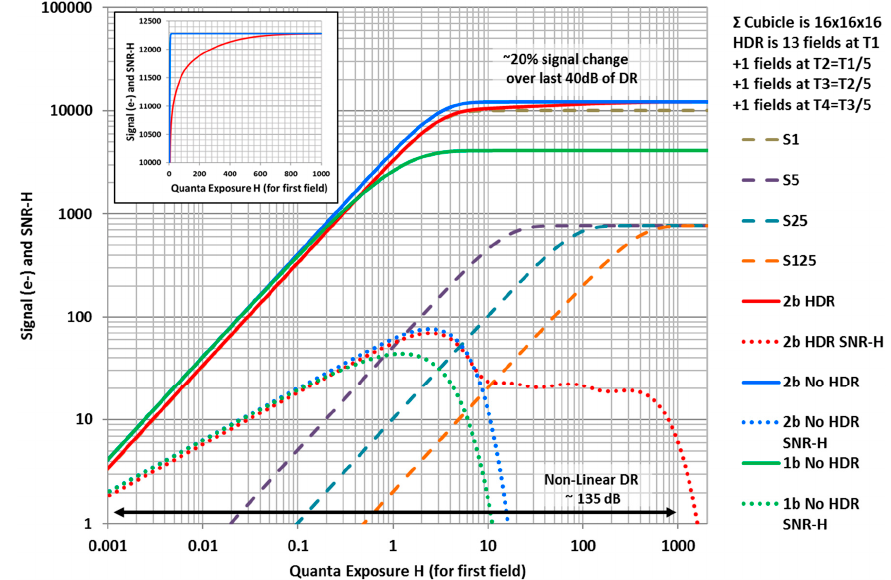
Figure 6. Log signal vs. log exposure for a 2b QIS operated in normal readout mode (blue) and high dynamic range mode (red), showing extension of the dynamic range by approximately 40 dB. Inset shows linear-scale response curves for the extended exposure range.